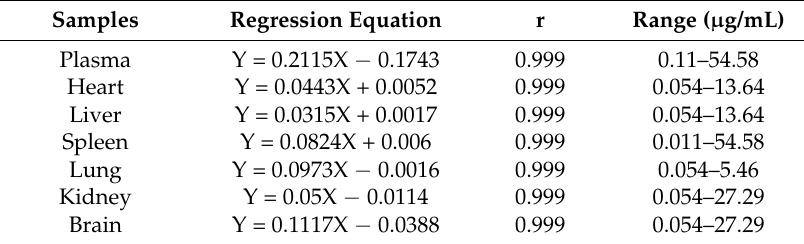
Table 1. The standard curve of BA in plasma and tissues.